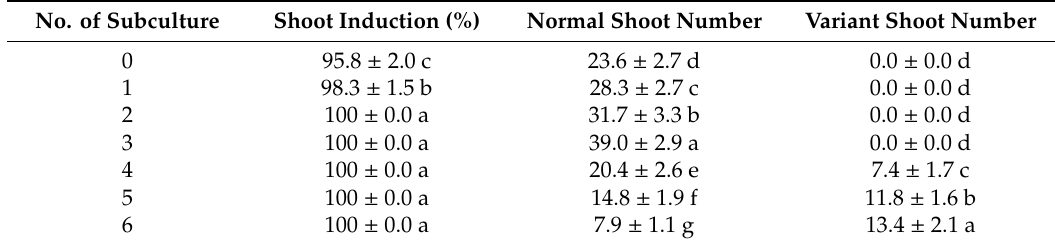
Table 5. E ff ect of subculture on shoot multiplication and somaclonal variation in Catharanthus roseus